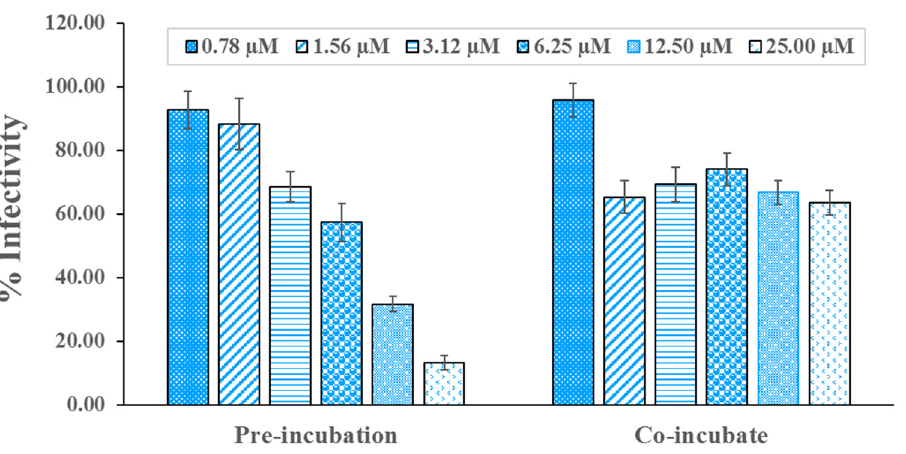
Figure 5. DB36 inhibits SARS-CoV-2 S-hACE2 mediated virus entry in a dose-dependent manner. SARS-CoV-2 S pseudotyped HIV was pre-incubated with DB36 at a concentration of 0.78, 1.56, 3.12, 6.25, 12.50, and 25.00 µM for one hour and infected to HEK293T/17-hACE2 overexpressing hTMPRSS2 (pre-incubation) or immediately infected to the cells (co-incubation). Infectivity of the virus was determined by measuring the activity of expressed luciferase reporter gene. Data are expressed as the relative mean value with an error bar (SEM) from 2–3 independent experiments (each performed in triplicate). Table 2. Antiviral infection activity of hit compounds .